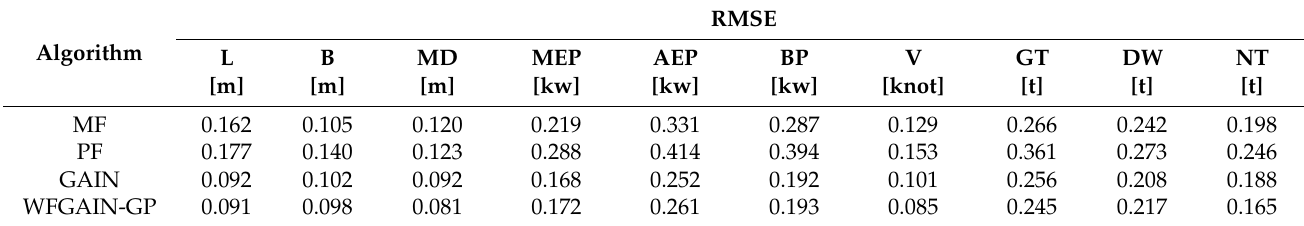
Table 10. RMSE values of imputation based on real missing rates.